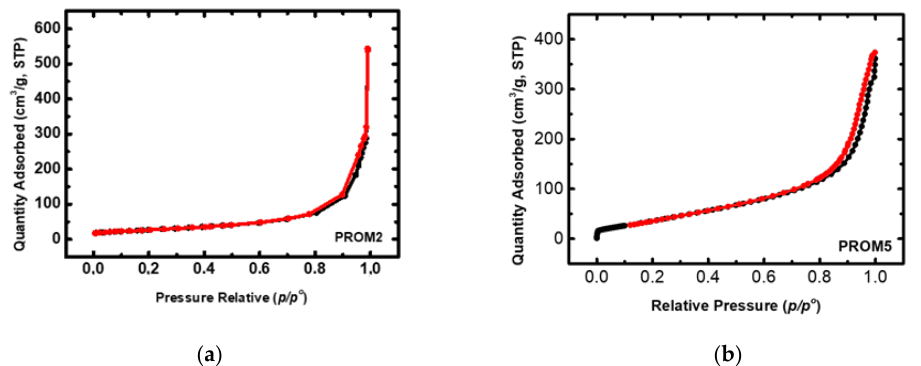
Figure 13. Isotherm curve of N 2 physisorption for Prometheus tri-metallic catalysts: ( a ) PROM2; ( b ) PROM5.